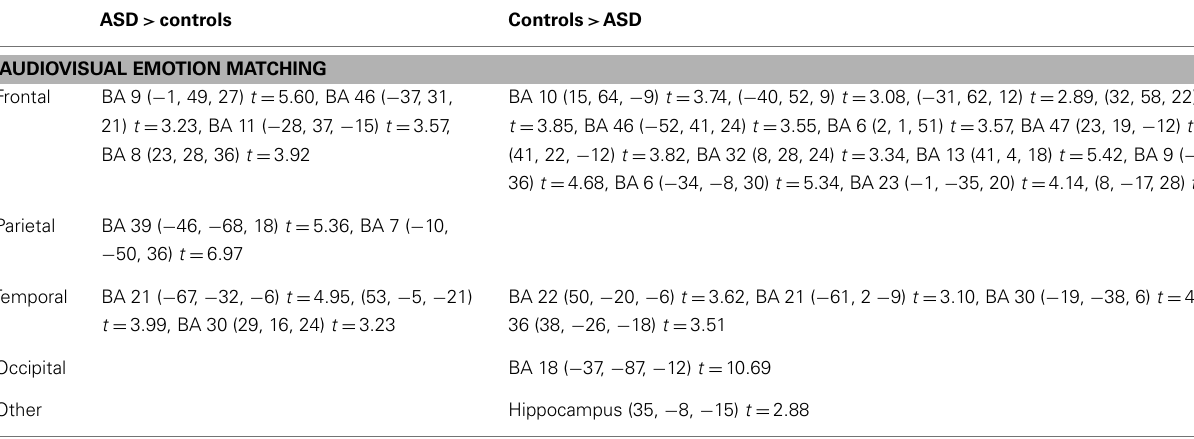
Table 4 | Significant differences in brain activity in teens with and withASD during audiovisual emotion matching.